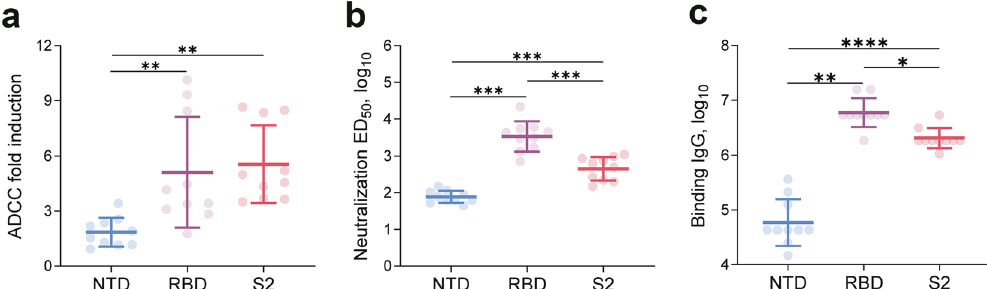
Fig. 3 Antibody and ADCC activities mediated by different domains of SARS-COV-2 spike (S) protein in mice. The SARS-COV-2 N-terminal domain (NTD), receptor-binding domain (RBD), and S2 subunit were analyzed. a ADCC fold induction in the three domains. b Neutralization ED50 (log10-transformed) in the three domains. c Binding IgG (log10-transformed) in the three domains. The mean and standard deviation are shown. Comparisons among the three groups were performed by one-way analysis of variance; * P < 0.05, ** P < 0.01, *** P < 0.001, **** P < 0.0001. ADCC antibody-dependent cell-mediated cytotoxicity, SARS-COV-2 severe acute respiratory syndrome coronavirus